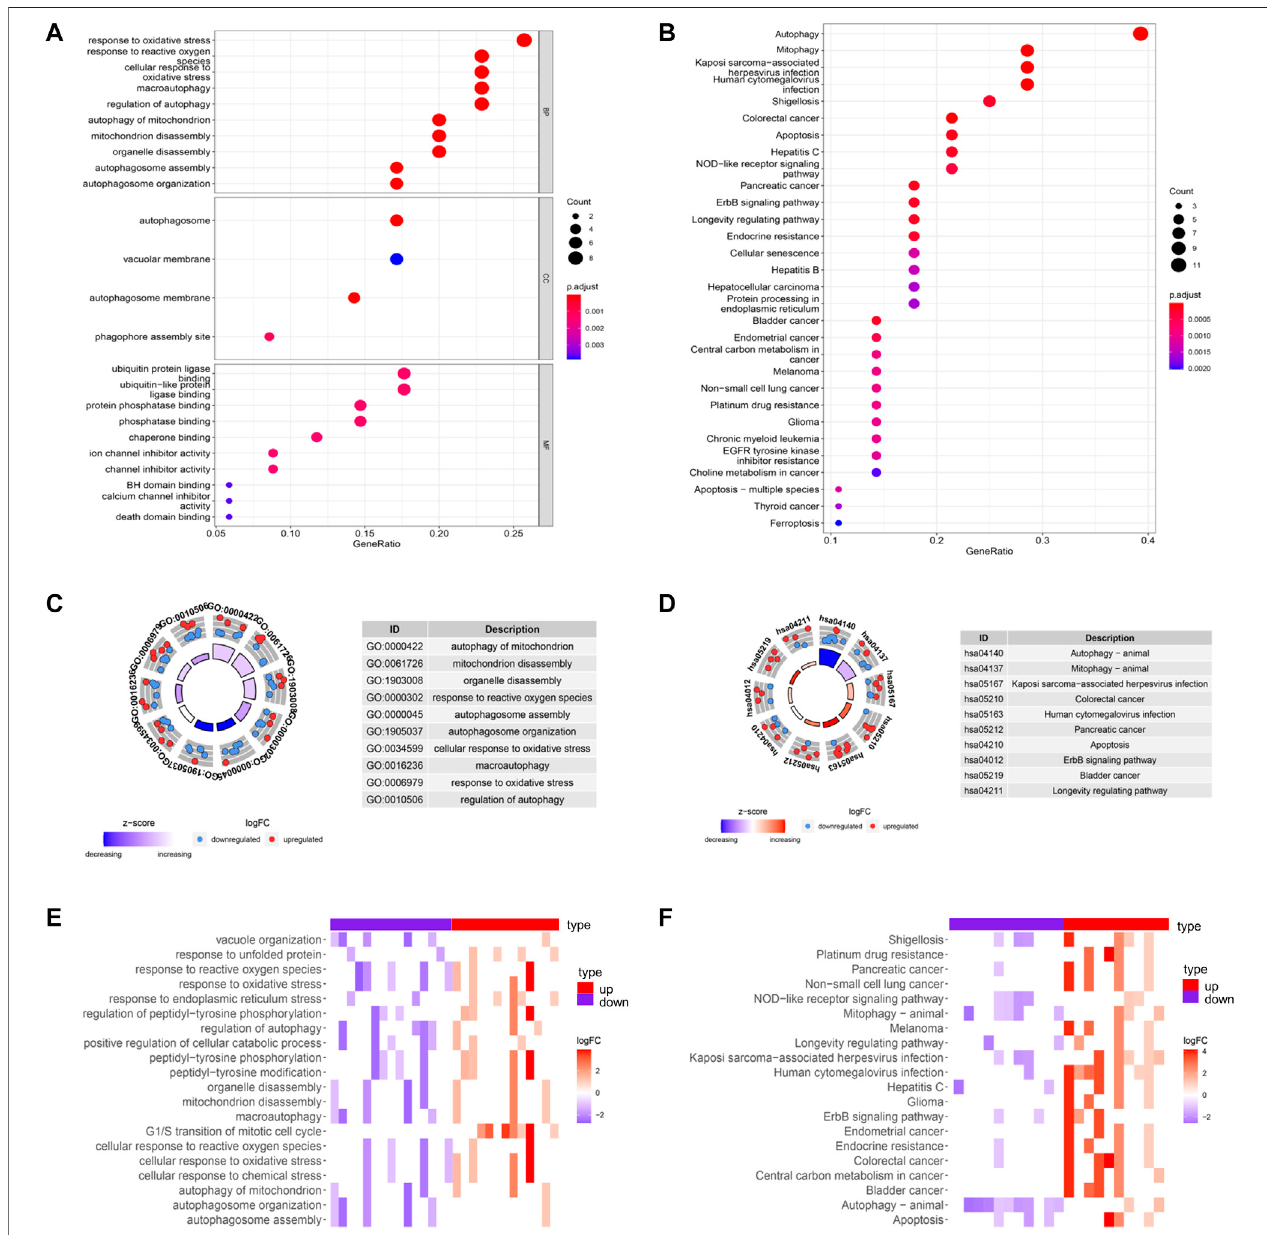
FIGURE 2 | GO and KEGG enrichments of DE-ARGs (A , B) showed the GO and KEGG enrichment analysis respectively. The larger bubble and darker color indicatedthemoresigni fi cantenrichmentprocess. (C , D) enrichmentpathwaysintheGOandKEGGcircleplots,respectively.Theinner-circleindicatedZ-score.Thered color represented the signi fi cant enrichment. The outer circle indicated the various pathways, in which the blue dots indicated down-regulated genes, and the red was up-regulated genes. (E , F) heat maps of GO and KEGG enrichment, respectively. The red color represented the up-regulated genes, and purple represented the down-regulated